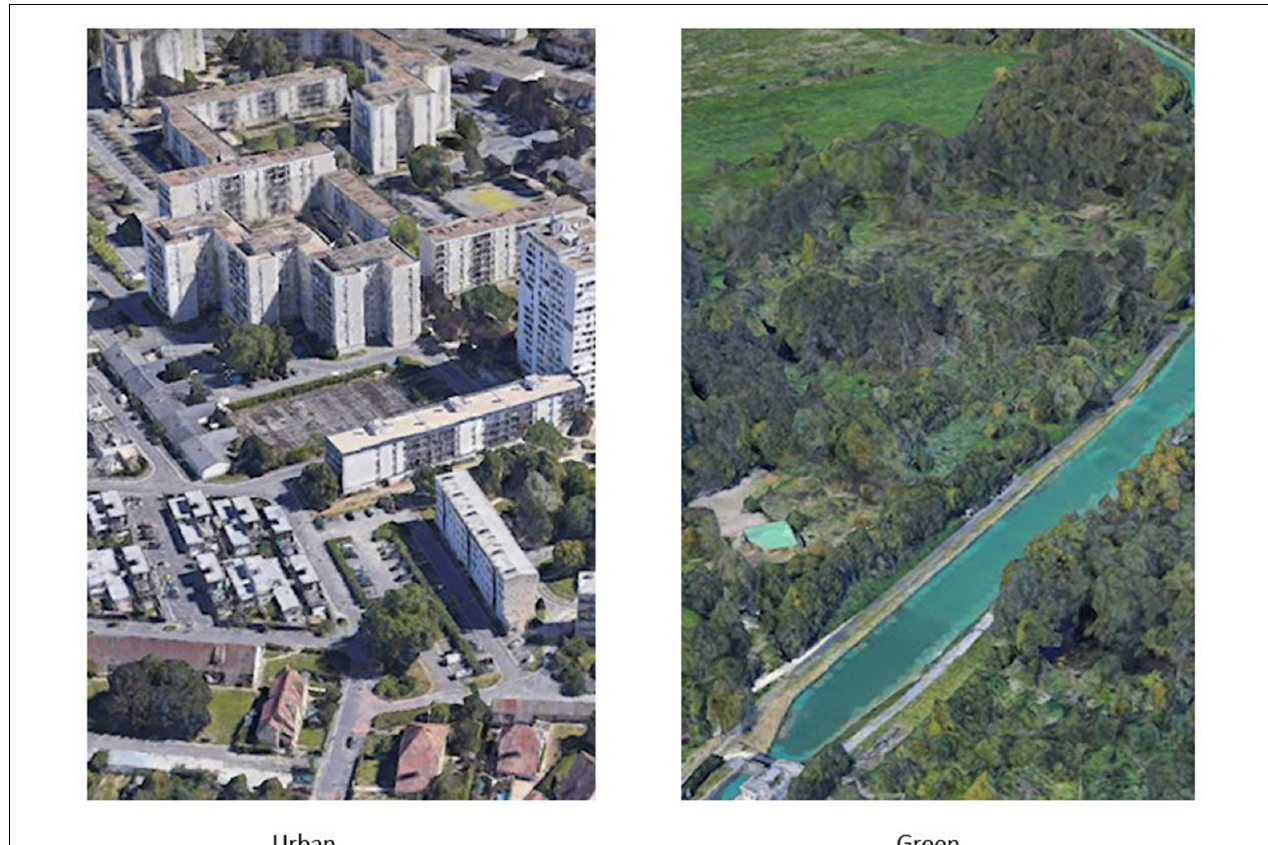
FIGURE 1 | Satellite images of exposure environments (Urban,